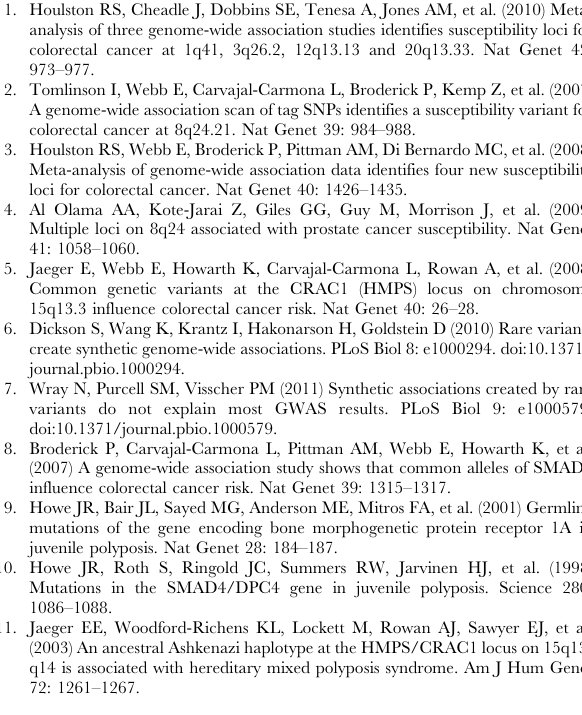
Table S4 TagSNPs around GREM1 , BMP4 , and BMP2 analysed for new associations. Table S5 Additional BMP pathway genes around which tagSNP associations with CRC were